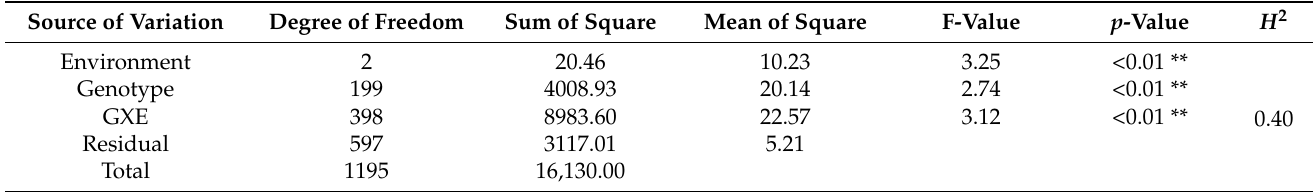
Table 2. Analysis of variance (ANOVA) and broad-sense heritability ( H 2 ) for maternal haploid inducibility (%) in the F 2 population.